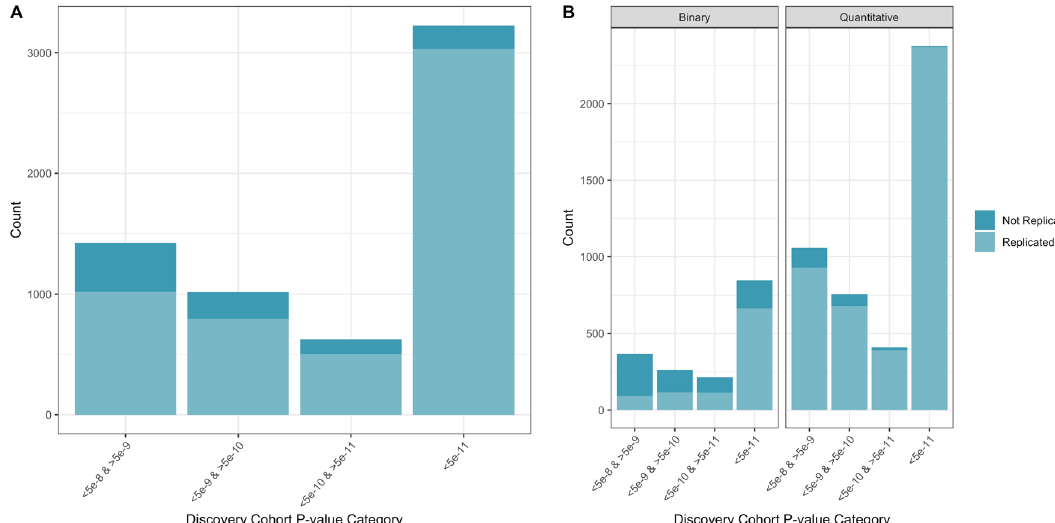
Figure 2. Replication of SNVs across P values.